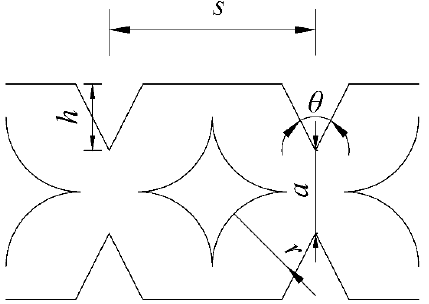
Figure 1. Schematic diagram of SWRLC unit structure.